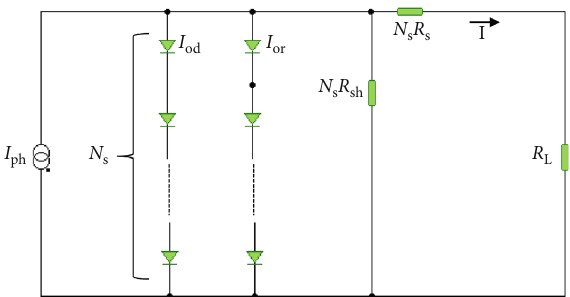
Figure 1: Equivalent circuits of photovoltaic panel. Two-diode